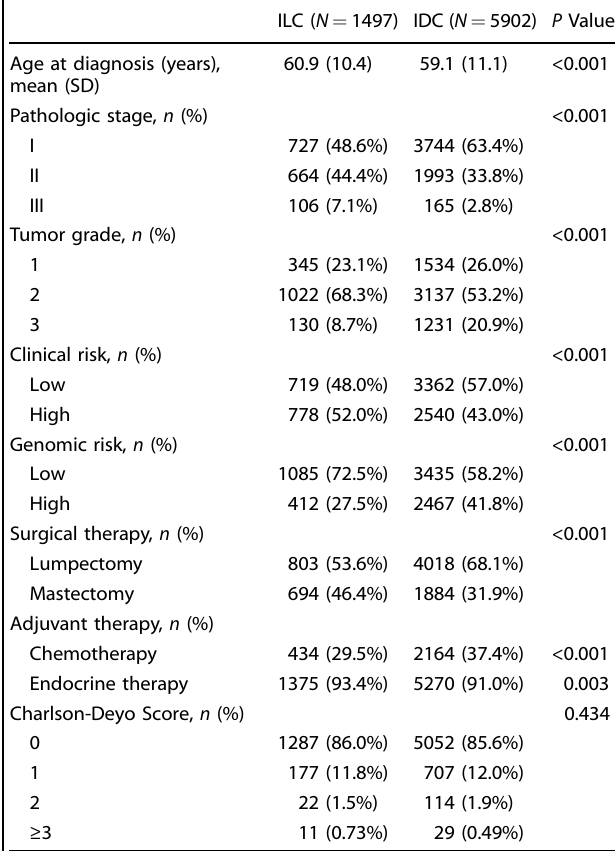
Table 1. Clinicopathologic characteristics of study